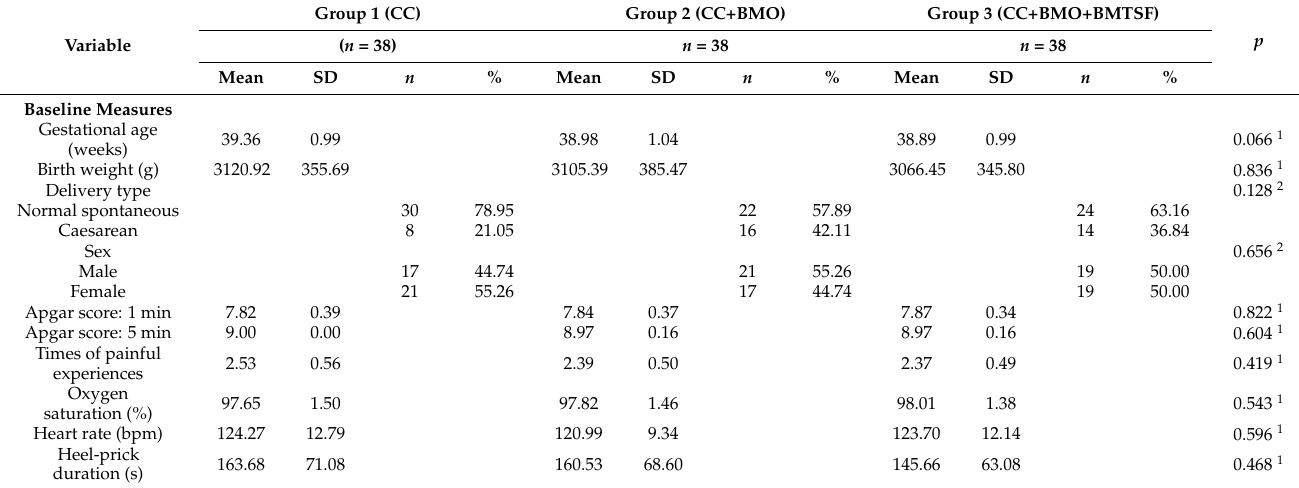
Table 1. Baseline characteristics and duration of heel-prick procedure for neonates in the three groups (N =